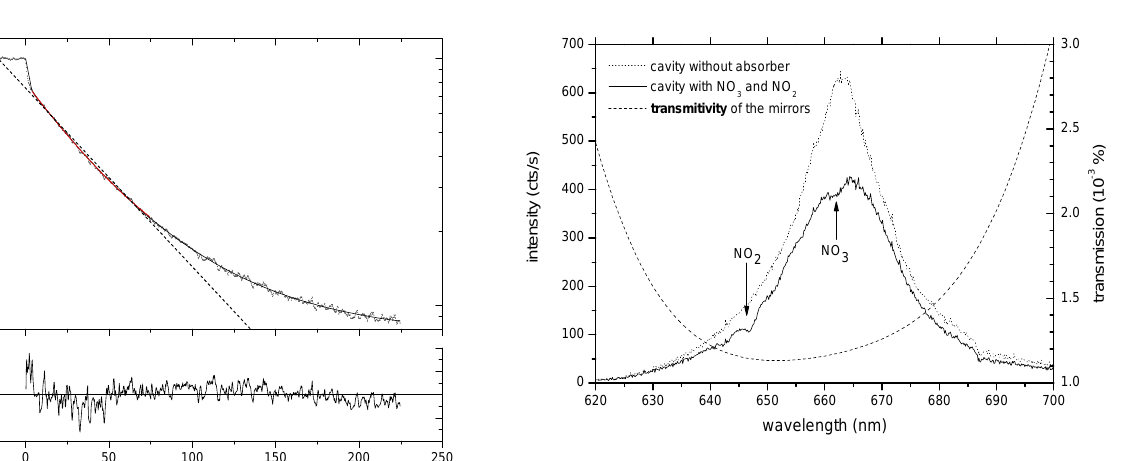
Fig. 3. Transmitted intensity of the resonator: integration time Figure 3. Transmitted intensity of the resonator: Integration time 10 x 5 s . The dotted line 3 10 × 5s. The dotted line shows the transmitted intensity of the empty shows the transmitted intensity of the empty cavity, which is the LED emission spectrum 4 cavity, which is the LED emission spectrum folded by the mirror folded by the mirror transmission. The solid line was recorded with approx. 0.3 ppbv NO 3 and 5 transmission. The solid line was recorded with approx. 0.3ppbv 810 ppbv NO 2 . The dashed line is the transmissivity of the high reflective mirrors as specified 6 NO 3 and 810ppbv NO 2 . The dashed line is the transmissivity of by the manufacturer. 7 the high reflective mirrors as specified by the